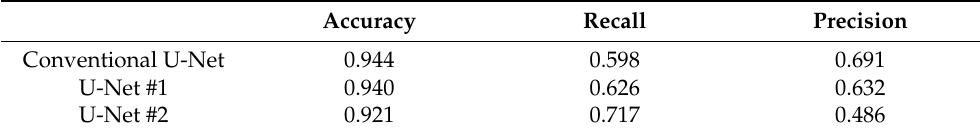
Table 2. Accuracy, recall, and precision (image with small number of particles).